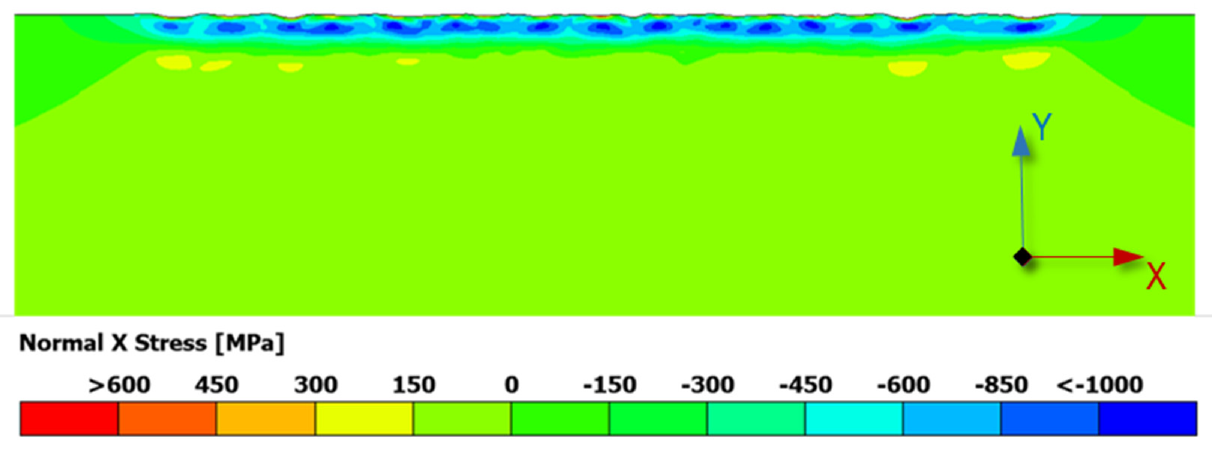
Figure 8. Stabilized compressive stress field after peening with S460 shots.